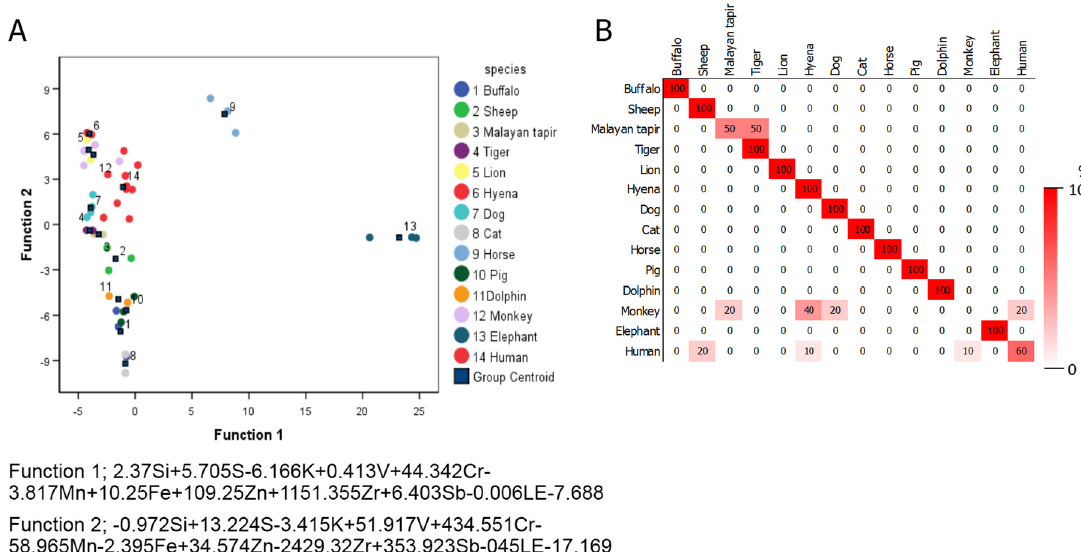
Fig 2. The feasibility of elemental composition in molar teeth for species classification. (A) Canconical discriminant function plots of the elemental composition of molar teeth of different species and (B) the classification results by discriminant analysis expressed as a percentage of the correct prediction.